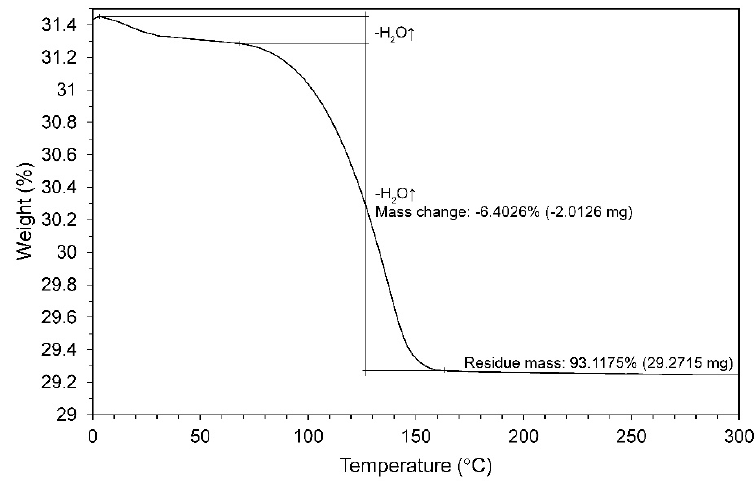
Figure 4. Thermogravimetry curve of the synthesized powder.